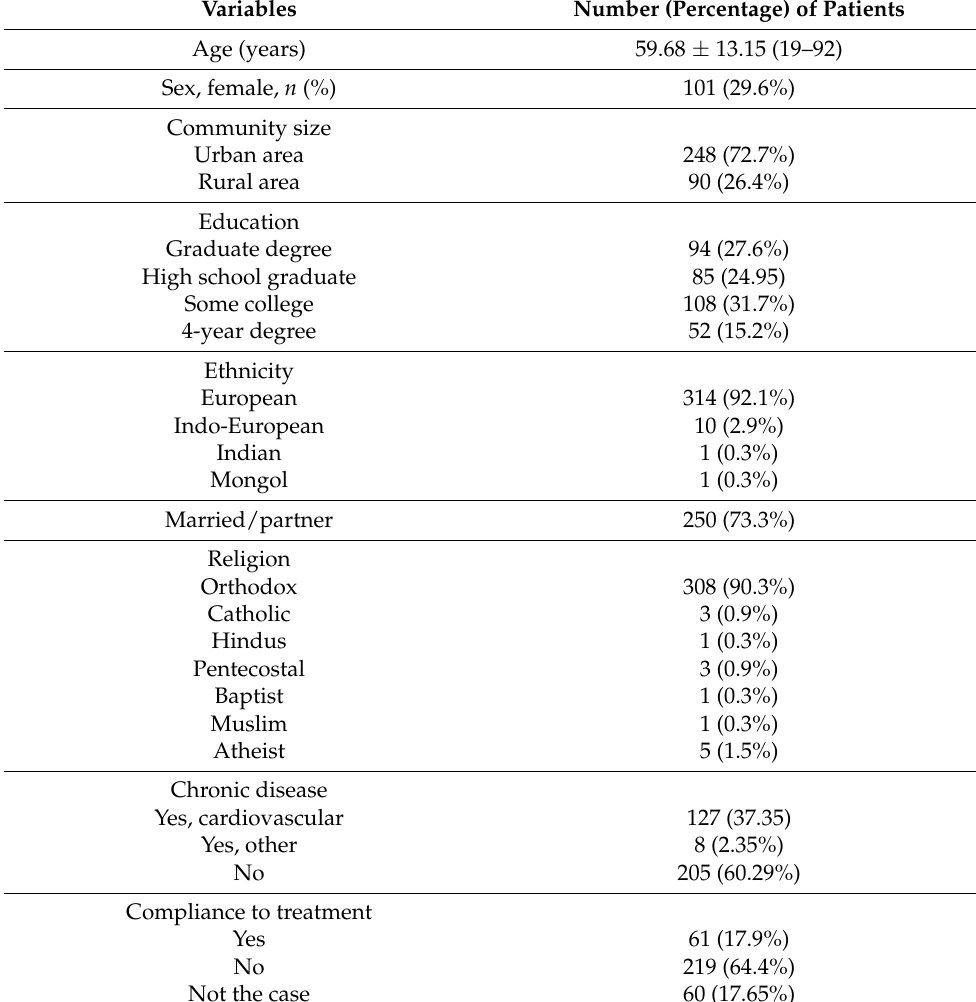
Table 1. Study population characteristics ( N =